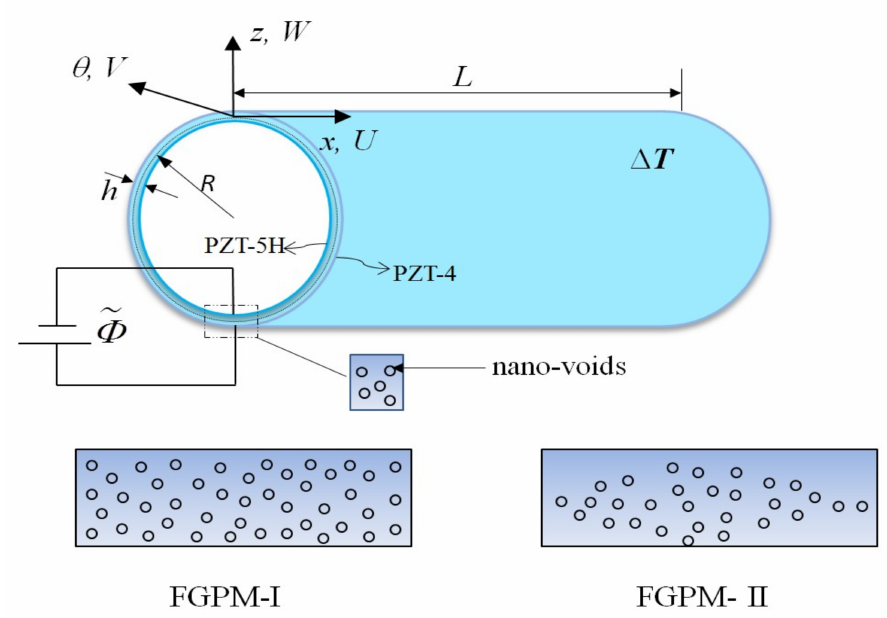
Figure 1. Schematic of a porous functionally graded piezoelectric material (FGPM) circular cylindrical